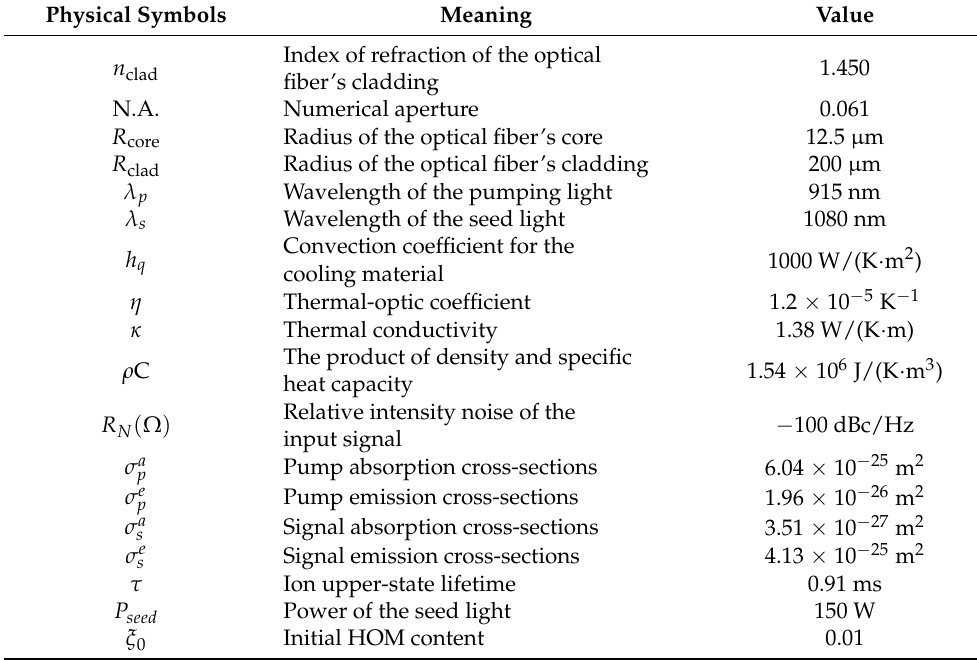
Table 1. Parameters of the fiber amplifier for